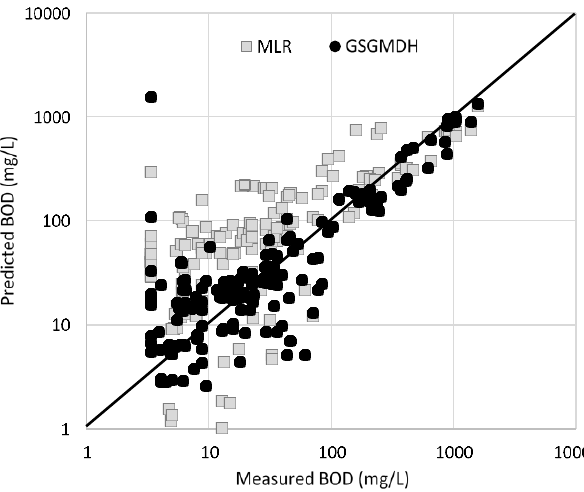
Figure 2. Measured versus Predicted treated BOD levels .